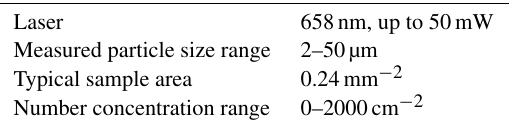
Table 3. Specifications of the in situ cloud droplet probe mounted on a tethered balloon.